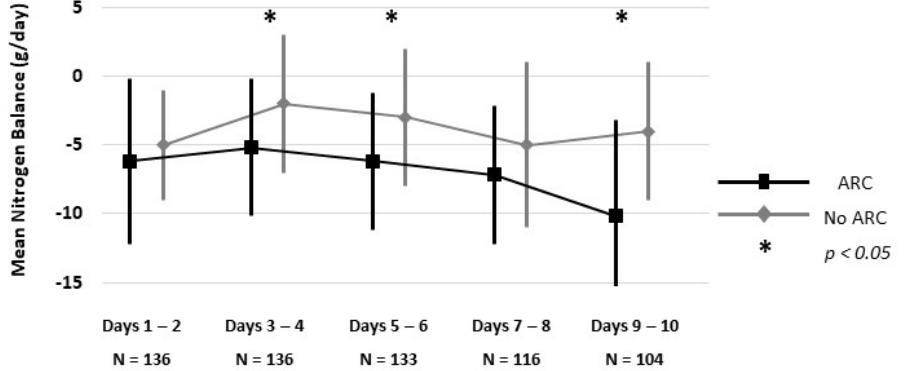
Figure 3. Distribution of nitrogen intake ( A ), urinary nitrogen loss ( B ) and nitrogen balance ( C ) compared in ARC vs. non-ARC patients over the study period. ARC: mean CL CR > 130 mL/min/1.73 m 2 over the five study periods; N = number of urinary samples allowing CL CR calculation over the five study periods.